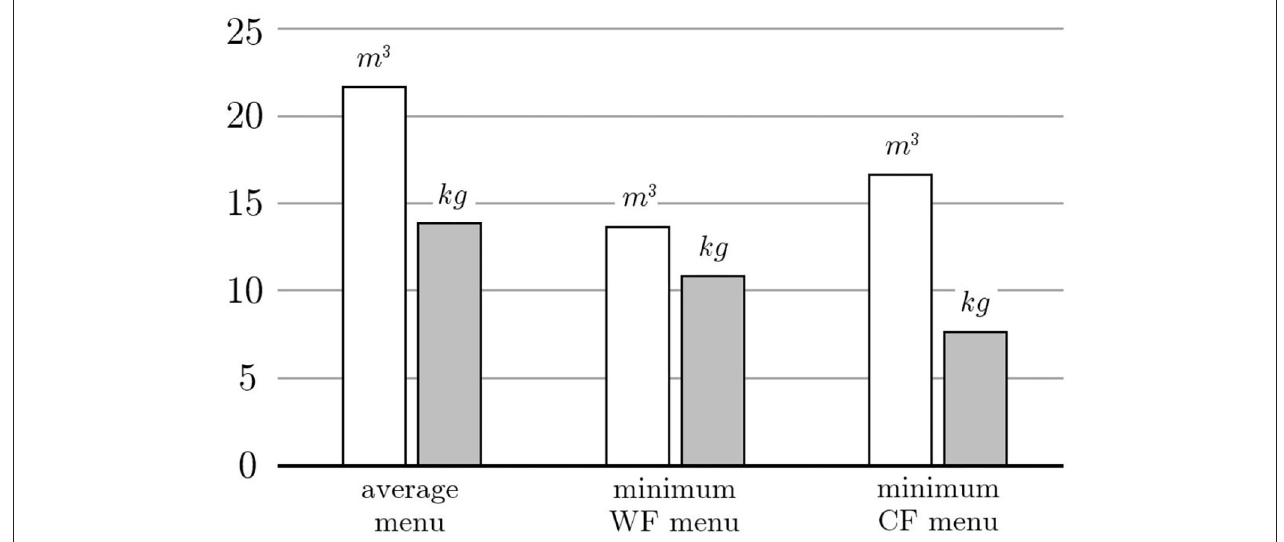
FIGURE 4 | The white and gray bars represent the water and carbon footprint of the average menu or those obtained by minimizing either the water or the carbon